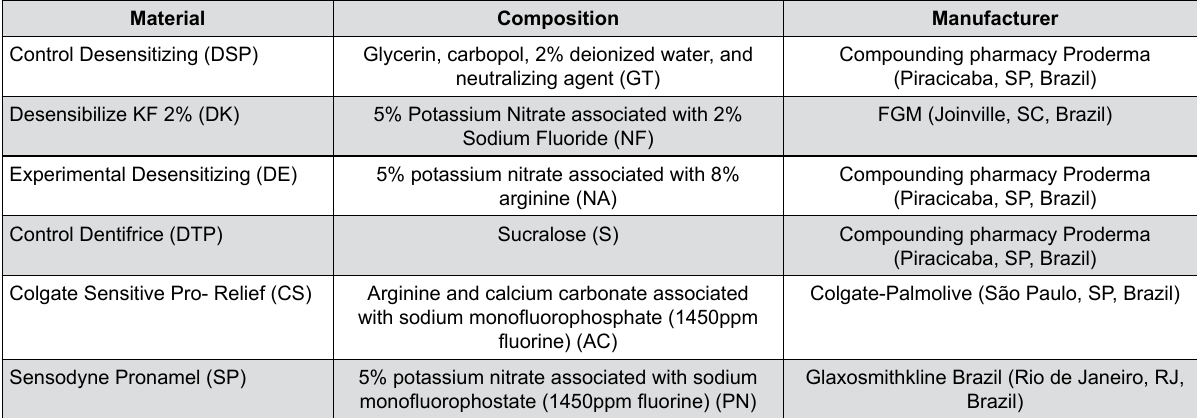
Figure 1- Description of the desensitizing products, their composition and manufacturers Groups